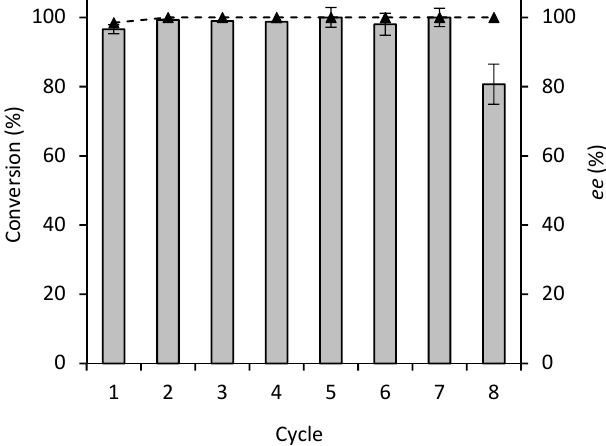
Figure 3. Recycling of wet At HNL-EziG Opal (10 U mg − 1 ) in eight successive cycles. Immobilization was performed by adsorption. Conversion (bars), enantiomeric excess (dotted line and triangles). Conditions: Ratio benzaldehyde : HCN in citrate/phosphate buffered MTBE, pH 5, 1:4, benzaldehyde (100 µL, 1 mmol), 2 mL HCN solution in citrate/phosphate buffered MTBE (1.5–2 M) pH 5, 27.5 µL (0.1 mmol) 1,3,5-triisopropylbenzene as I.S. and a teabag filled with At HNL immobilized on 60 mg EziG Opal. Mol ratio of monomeric At HNL:Fe 3+ was 1:5. The reaction was stirred at 900 rpm at room temperature. The enzyme was washed for 1 min with 100 mM citrate/phosphate buffer saturated MTBE pH 5 after each cycle. Reaction time: 1 h. Error bars correspond to the standard deviation of duplicates ( n = 2).